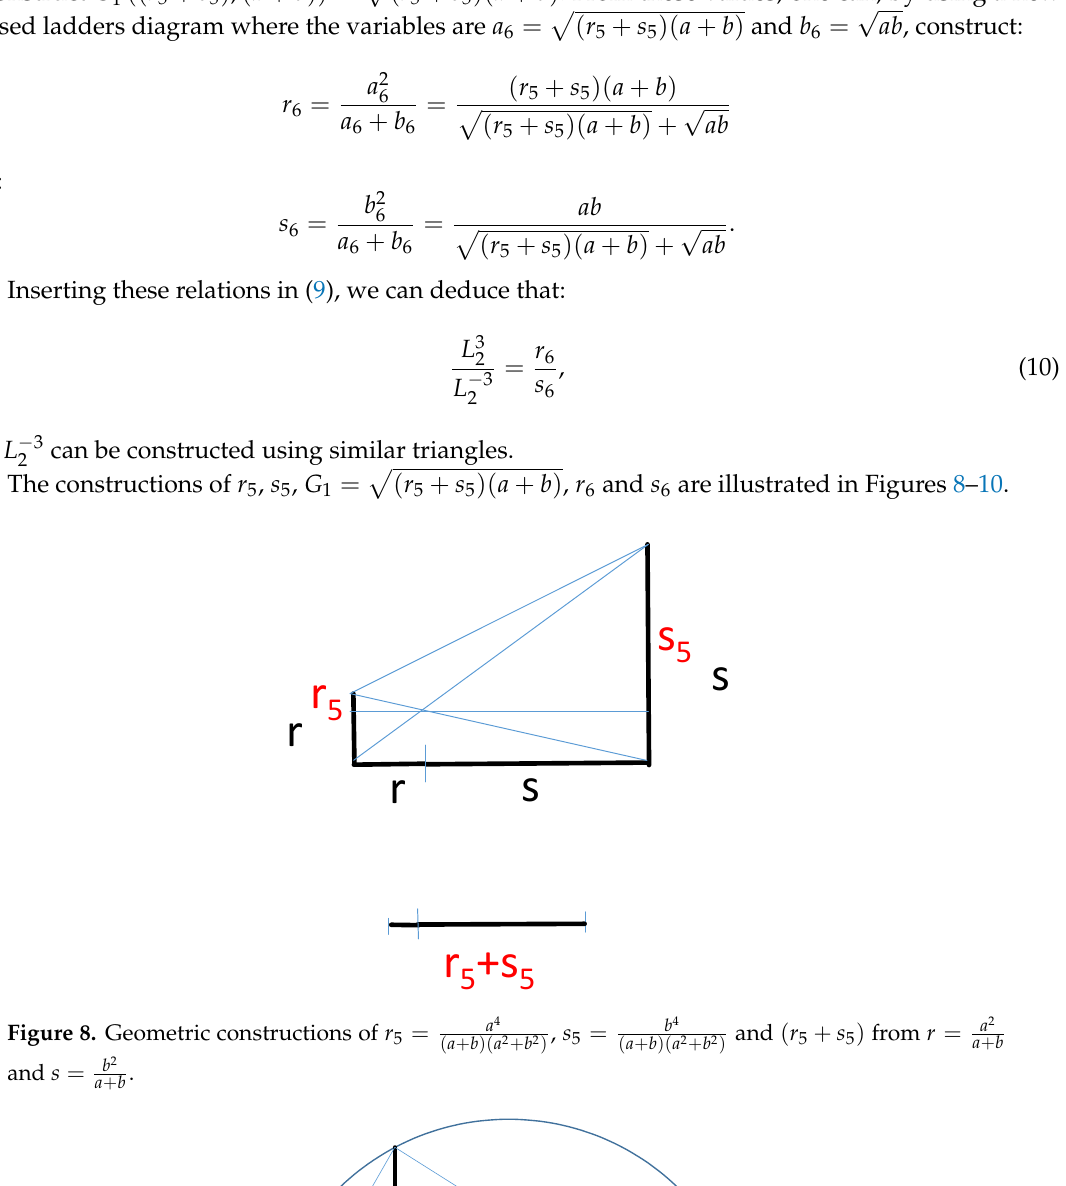
, s 5 = b 4 and ( r 5 + s 5 ) from r = a 2 ( a + b )( a 2 + b 2 ) ( a + b )( a 2 + b 2 ) a + b = a 4 , s = b 4 and ( r + s ) from r = a 2 5 5 5 5 ( a + b )( a 2 + b 2 ) ( a + b )( a 2 + b 2 )